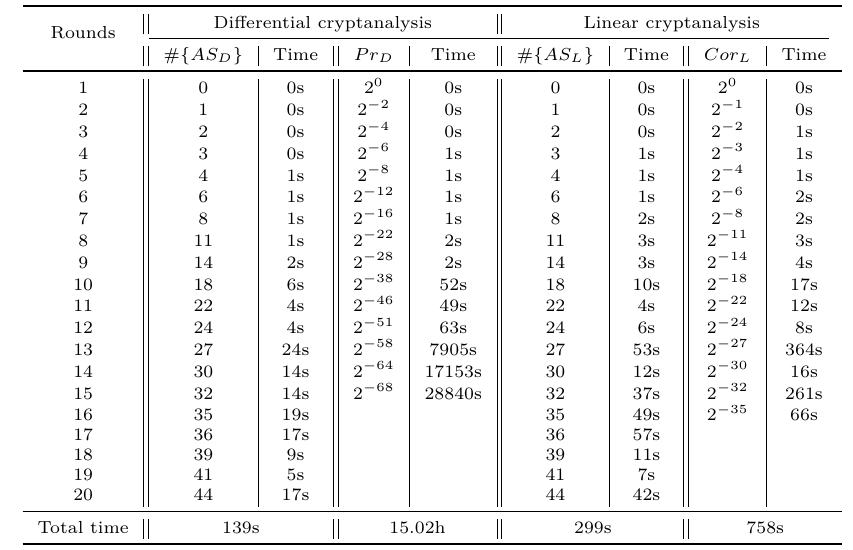
Table 6: Experimental results of